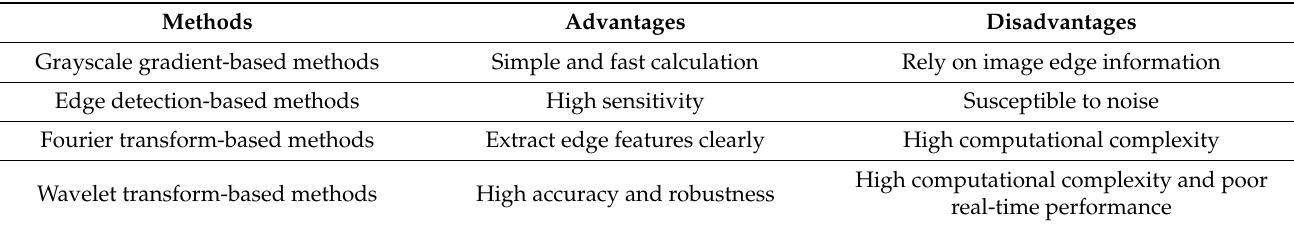
Table 1. Advantages and disadvantages of different methods based on spatial/spectral domain.